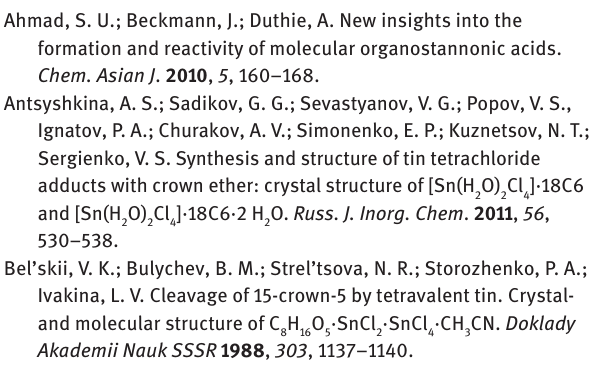
Cl (OEt) (HOEt) showing 50% 2 6 2 2